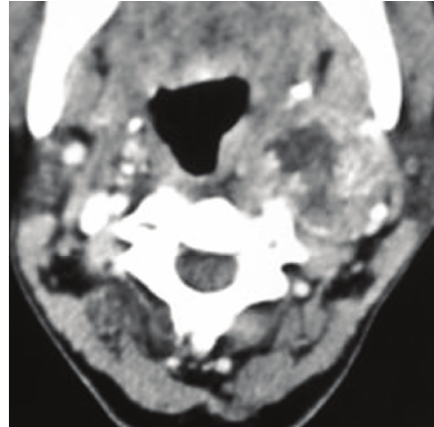
Figure 3: Computed tomography of the neck shows heteroge- neously enhancing hypodense mass in left carotid space causing splaying of carotid bifurcation.